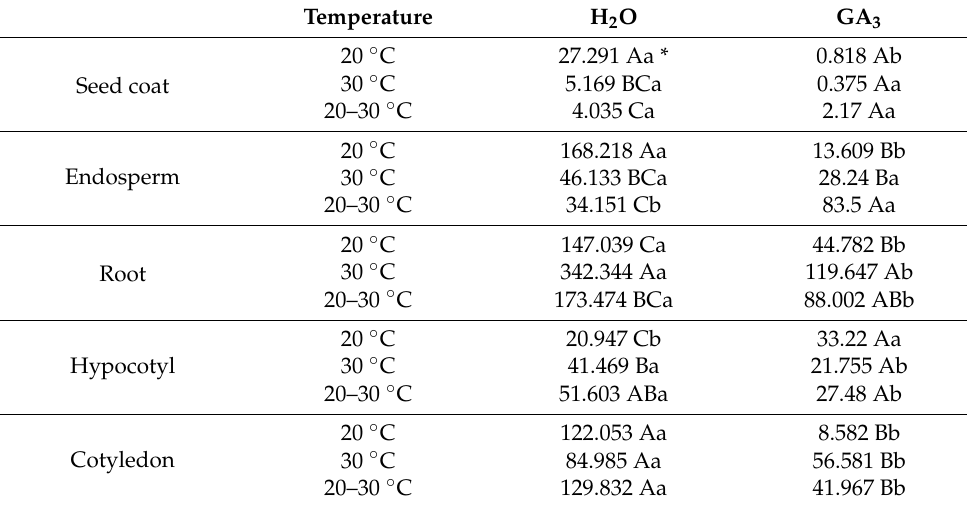
Table 5. Concentration of total alkaloids ( µ g g − 1 dry mass) in seedling structures (seed coat, en- dosperm, root, hypocotyl, and cotyledon) originating from Annona x atemoya Mabb. cv. ‘Gefner’ seeds immersed for 36 h (with H 2 O or GA 3 ) at temperatures of 20 ◦ C, 30 ◦ C, and 20–30 ◦ C and kept at the same temperatures during early development.